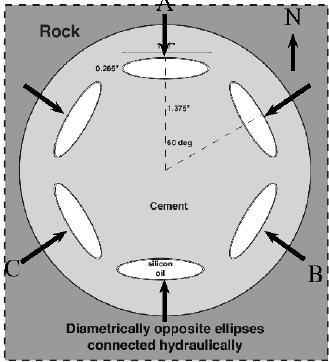
Figure 2. Representation of the MOK strainmeter orientation. Top view across the strainmeter and the borehole. Cylinders diametrically opposite are hydraulically connected, adding the effect of traction upon their surface. The gauge s1a (A) has an north azimuth direction and s1b (B) and s1c (C) are respectively 120 ◦ CW and CCW from s1a (top view).